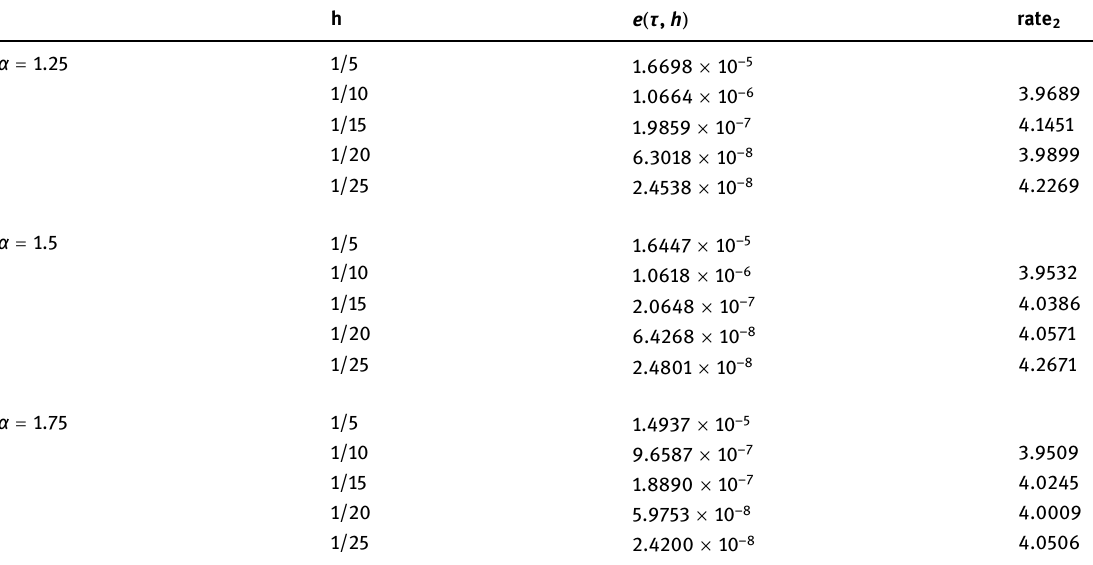
Table 5: Maximum norm errors and spatial convergence orders of the proposed scheme when = / τ 1 1,000 for Example